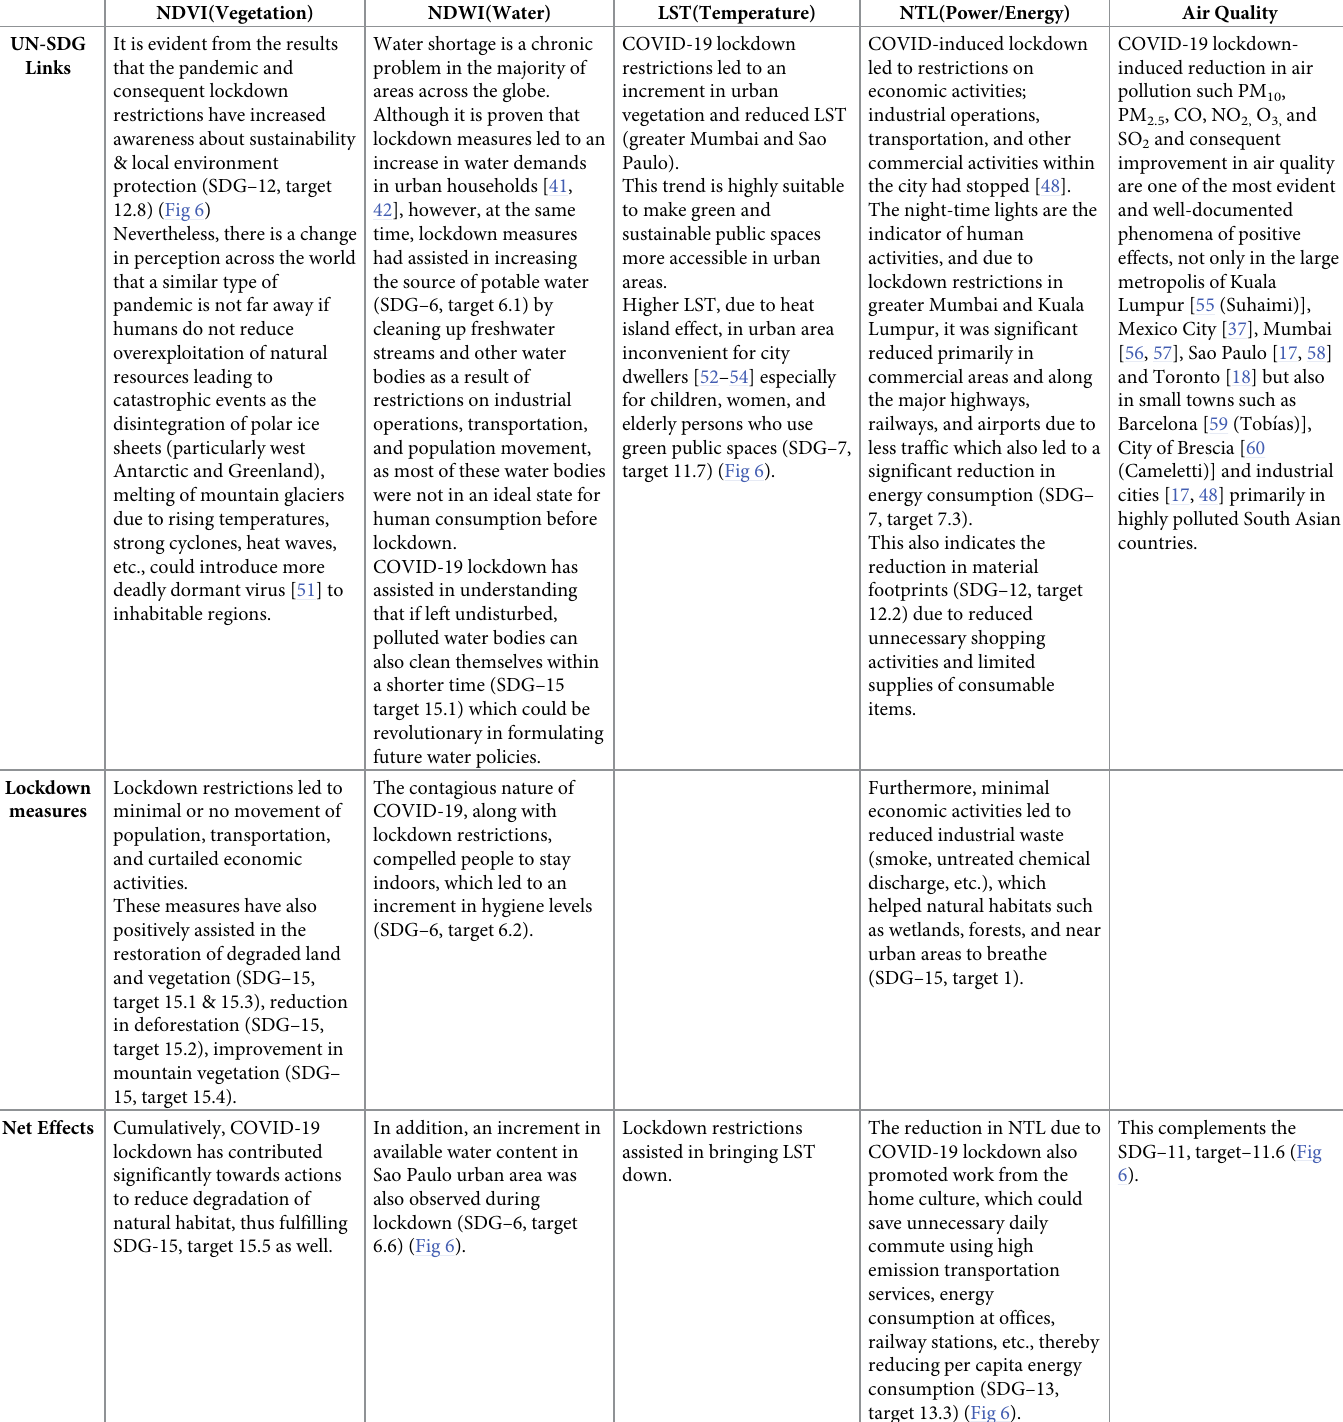
Table 2. Lockdown and its link to environmental parameters and UN-SDG targets.